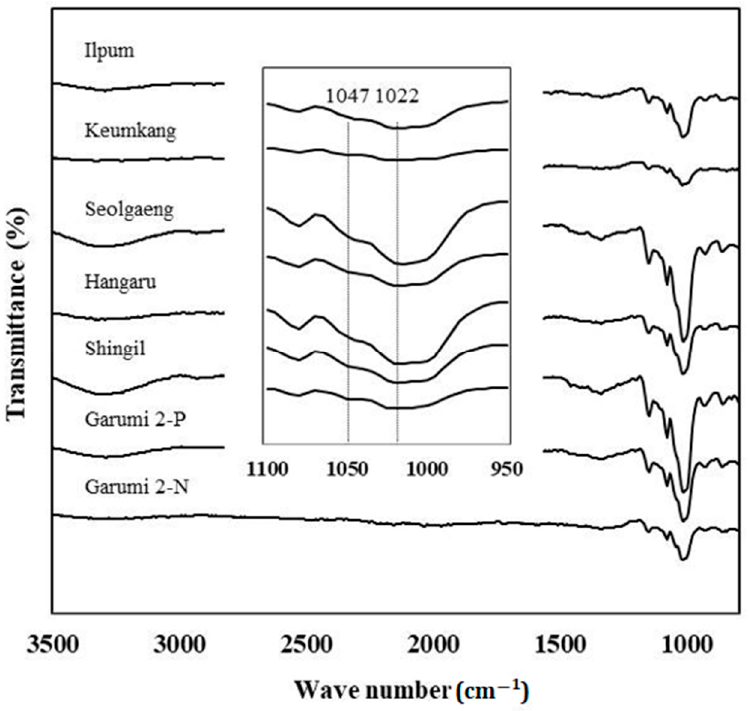
Figure 4. FT-IR spectra of starches from six rice varieties and one wheat variety for flour.